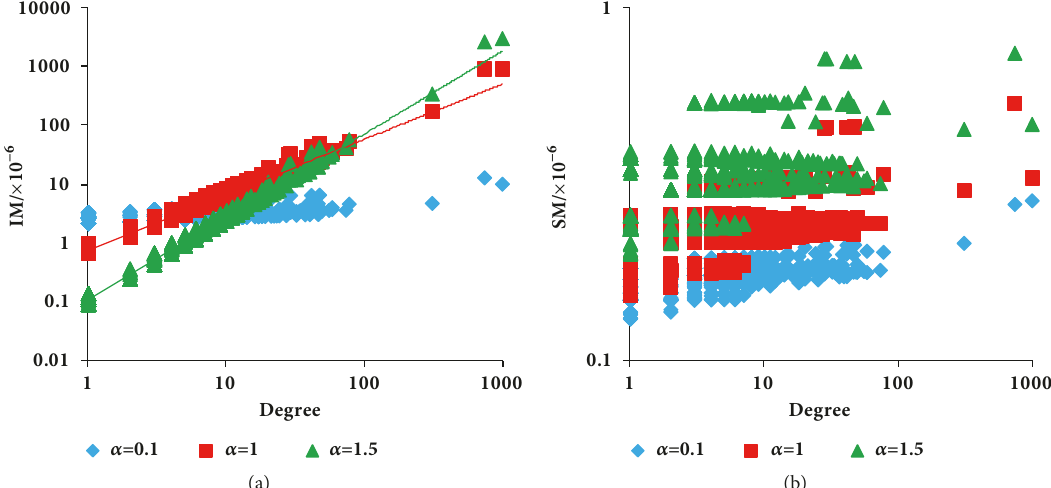
Figure 8: The relationship between metrics and degree in between. (a)IM and